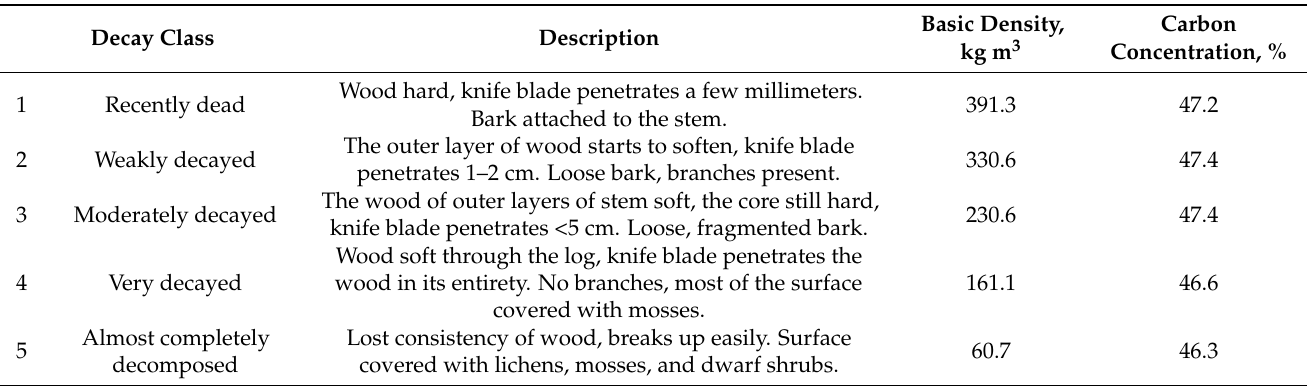
Table 2. Description of decay classes, density (dry weight per raw volume), and carbon concentration [38]. Basic density and carbon concentration are applied from Köster et al. [39].